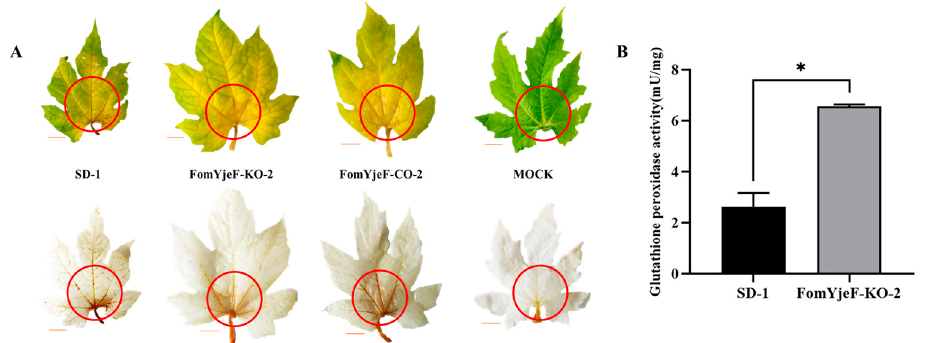
Figure 5. The deletion of FomYjeF affected the ROS accumulation and sensibility to oxidative stress of Fusarium oxysporum f. sp. momordicae . ( A ) The wild-type strain SD-1, FomYjeF-KO-2, and FomYjeF- CO-2 were inoculated to bitter gourd leaves of similar size and physiological state in the same part. MOCK leaf was inoculated with PDA. The red circle indicates the site of the disease and observation part. Bars: 1 cm. ( B ) Glutathione peroxidase activity in SD-1 and FomYjeF-KO-2. * over the histogram indicates the standard error of the mean (SEM) at p < 0.05 ( t -test). Ns indicates no significant difference. Error bars represent the SEM of three biological replicates with three technical replicates.